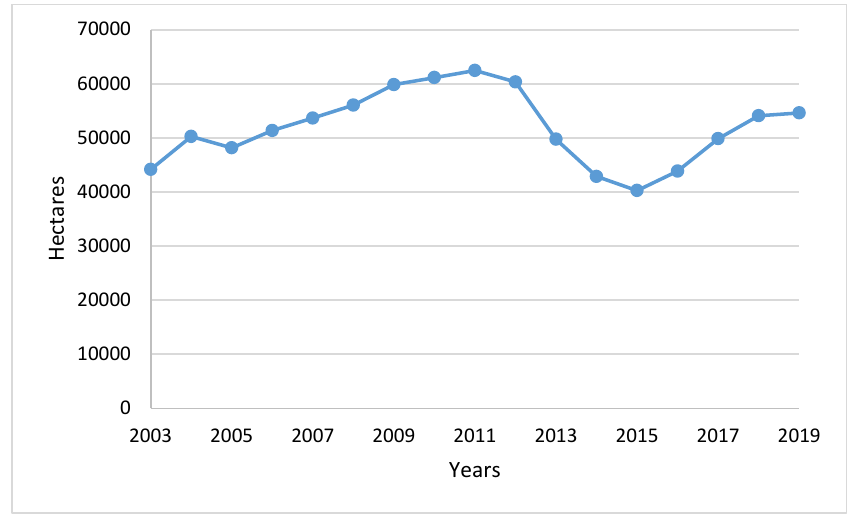
Fig. 3. Coca leaf crops